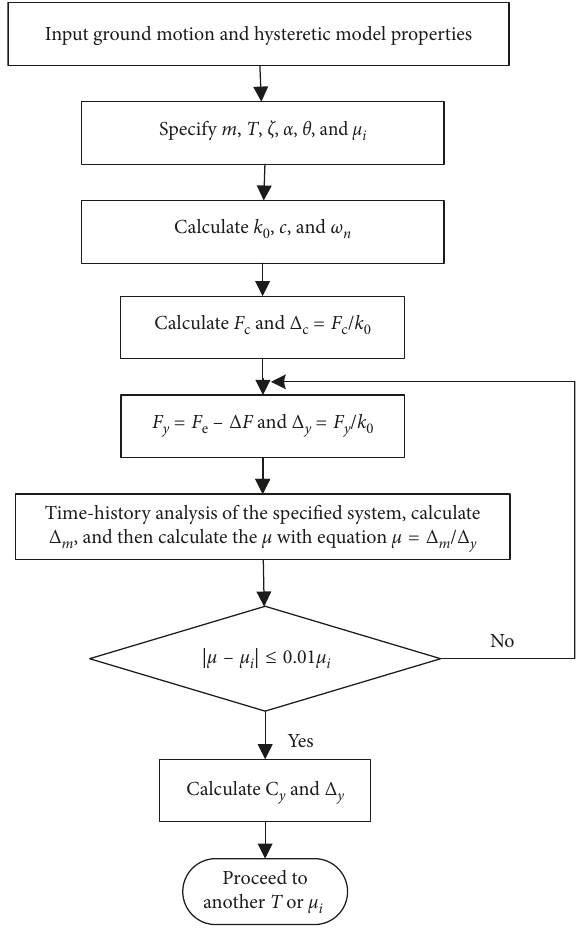
Figure 3: Flowchart for computation of